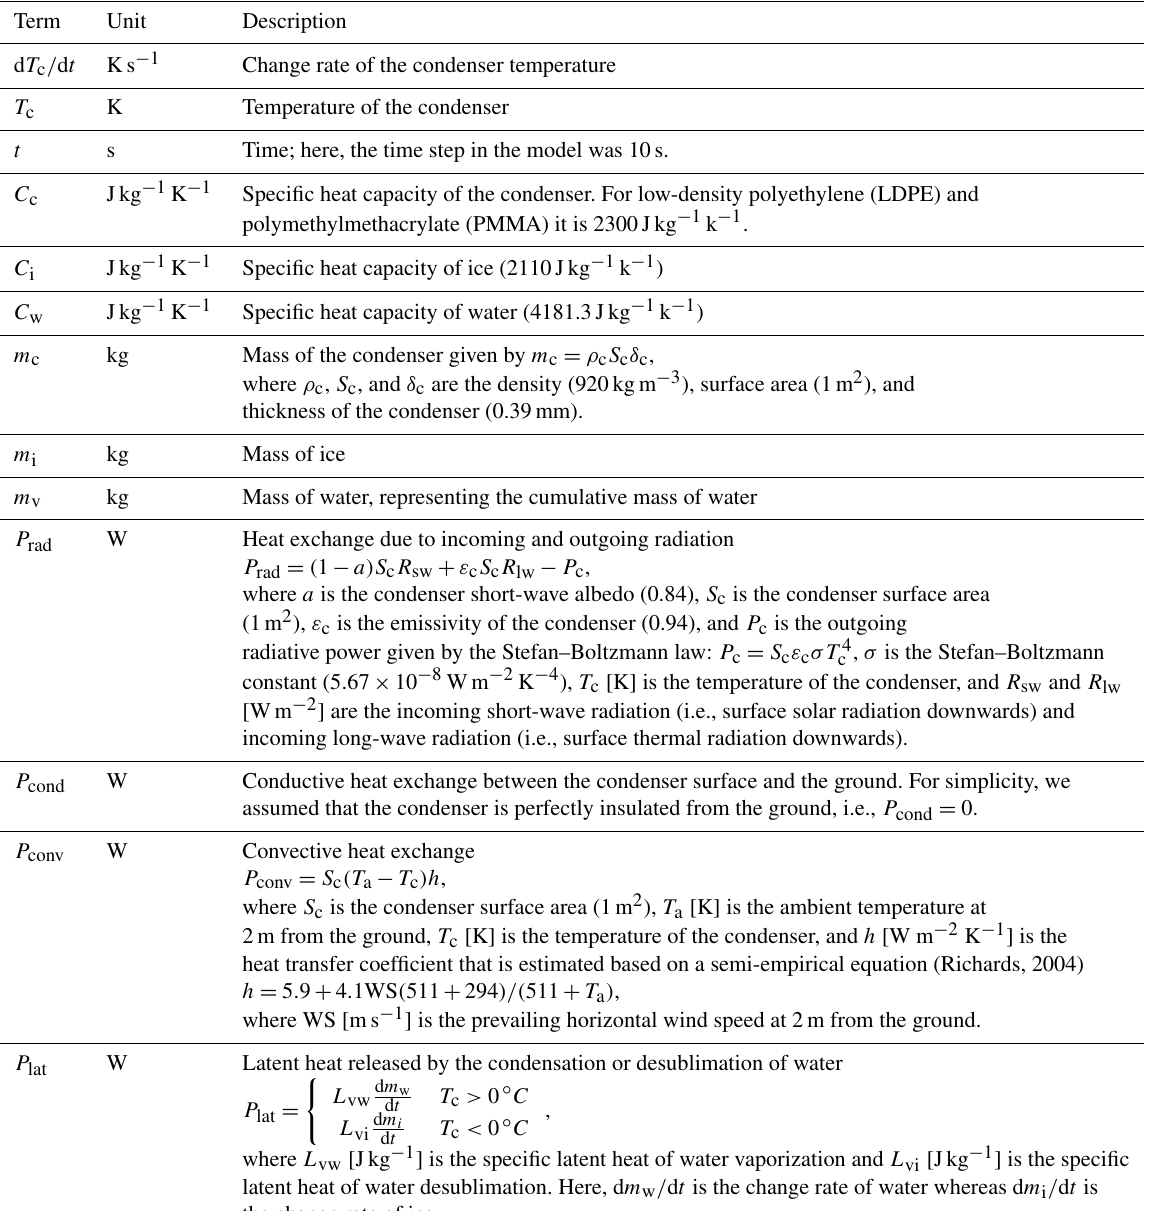
Table 2. Description of the dew formation model by listing the terms in Eq. (1). Term Unit Description d T c / d t Ks − 1 Change rate of the condenser temperature T c K Temperature of the condenser t s Time; here, the time step in the model was 10s. C c Jkg − 1 K − 1 Specific heat capacity of the condenser. For low-density polyethylene (LDPE) and C i C w